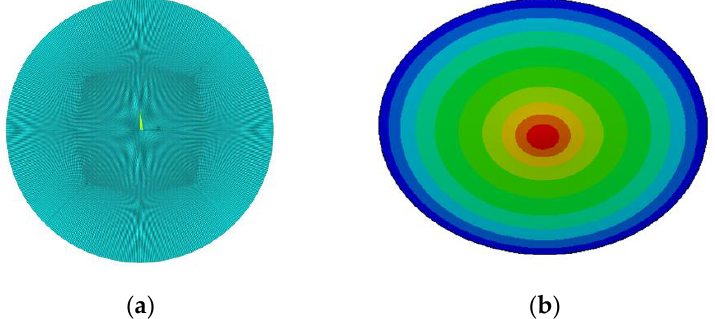
Figure 7. Verification of this study. ( a ) FE model; and ( b ) simulated deformation.